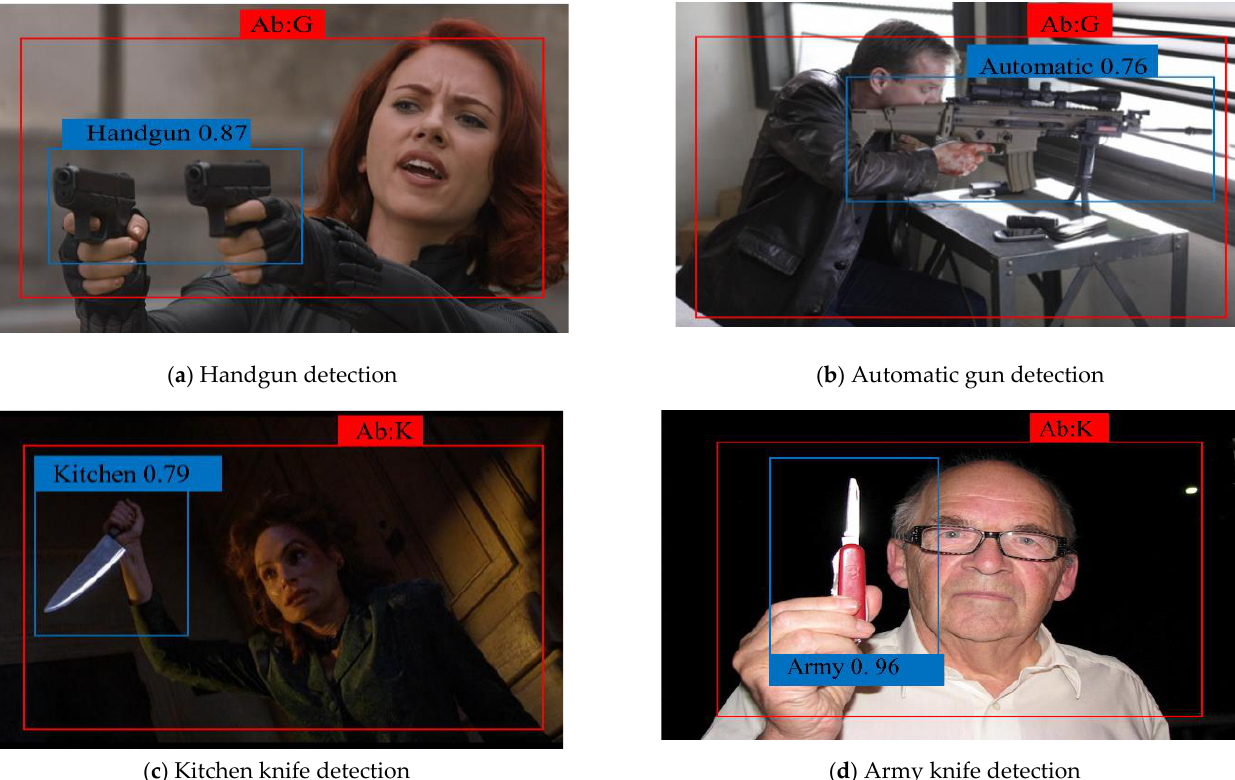
Figure 10. The accuracy of each subclass with respect to the trained batches of images. The red rectangle box determines an abnormal frame, and the blue rectangle box defines the detected subclass.